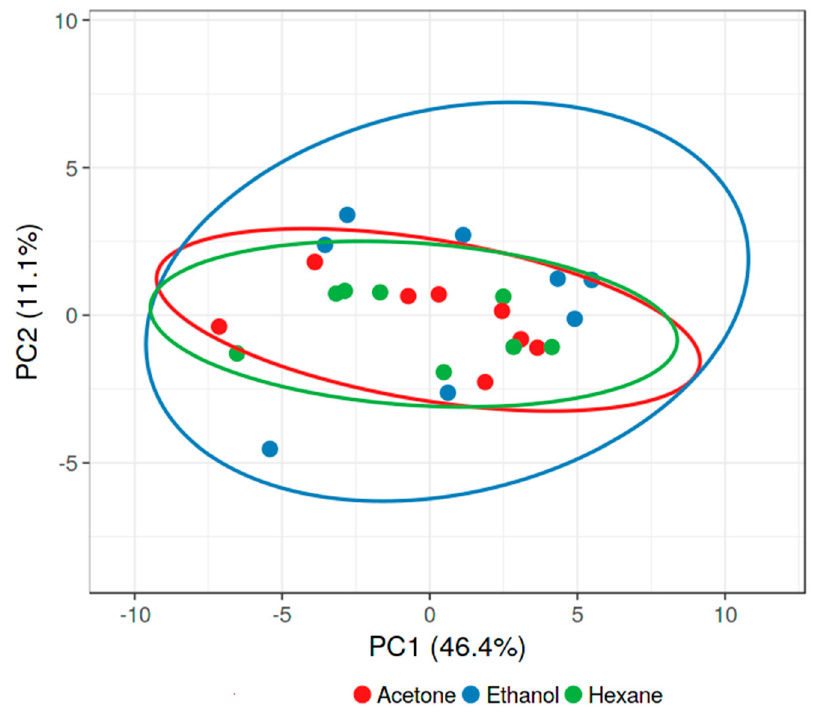
Figure 1. Principal component analysis of antibacterial activity (prediction ellipses with probability 0.95, N = 24 data points).